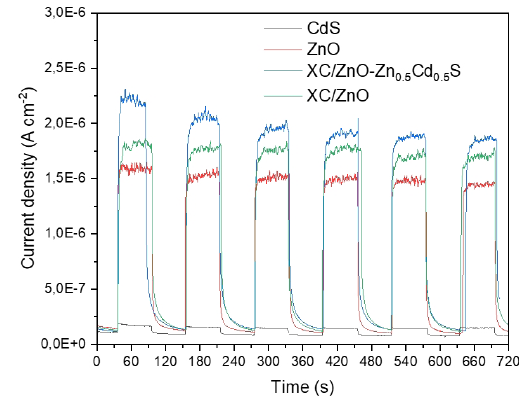
Figure 11. Chronoamperometry results for the materials synthesized.